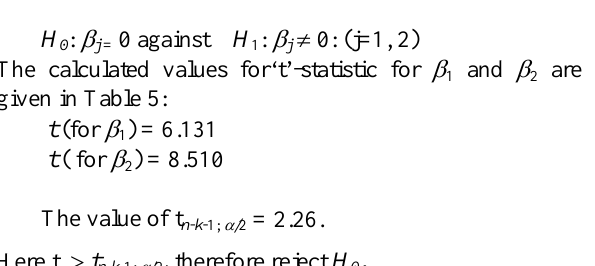
T-test (for Testing Individual β ’s of Multiple Linear Regression